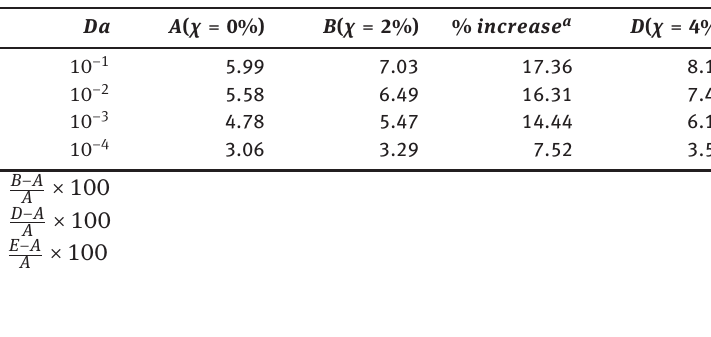
Fig. 11: Average Nusselt numbers: (a) the effects of Ri , (b) the effects of Da , (c) the effects of ϵ , with different L H and γ 2 , and (d) the effects of χ with different Da . Table 5: The comparison of the average Nusselt number for different Darcy number and various solid volume